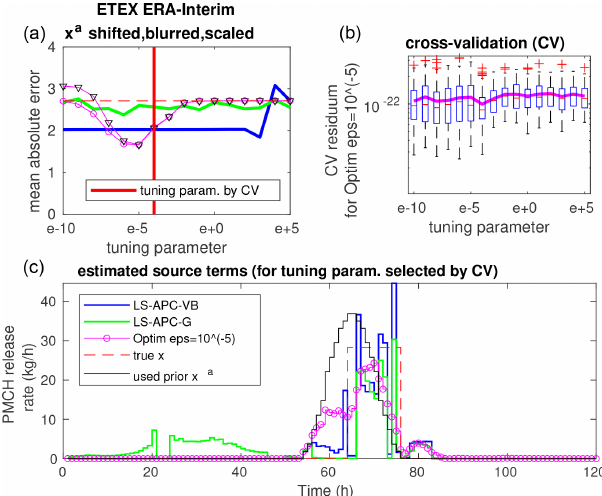
Figure 6. Same as Fig. 5 for the ETEX ERA-Interim dataset with x a shifted, scaled, and blurred.